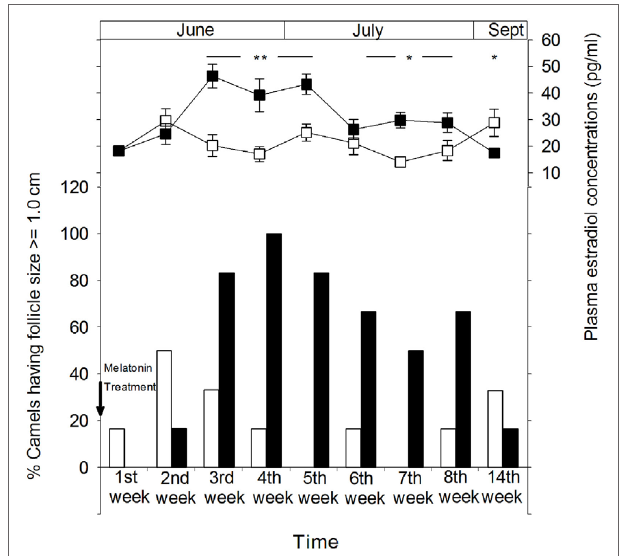
FigUre 3 | Ovarian cyclical activity in camel females of the melatonin-treated group ( ◾ ) and control group ( ◽ ) determined by sonographic monitoring of the follicular diameter and plasma estradiol concentrations. The figure shows the percentage of camels with a follicle size of ≥ 1.0 cm. Time is presented as days relative to insertion of melatonin implants. The significance levels for differences between treatments (ANOVA) are indicated: * P < 0.05, ** P < 0.01, and *** P < 0.001.